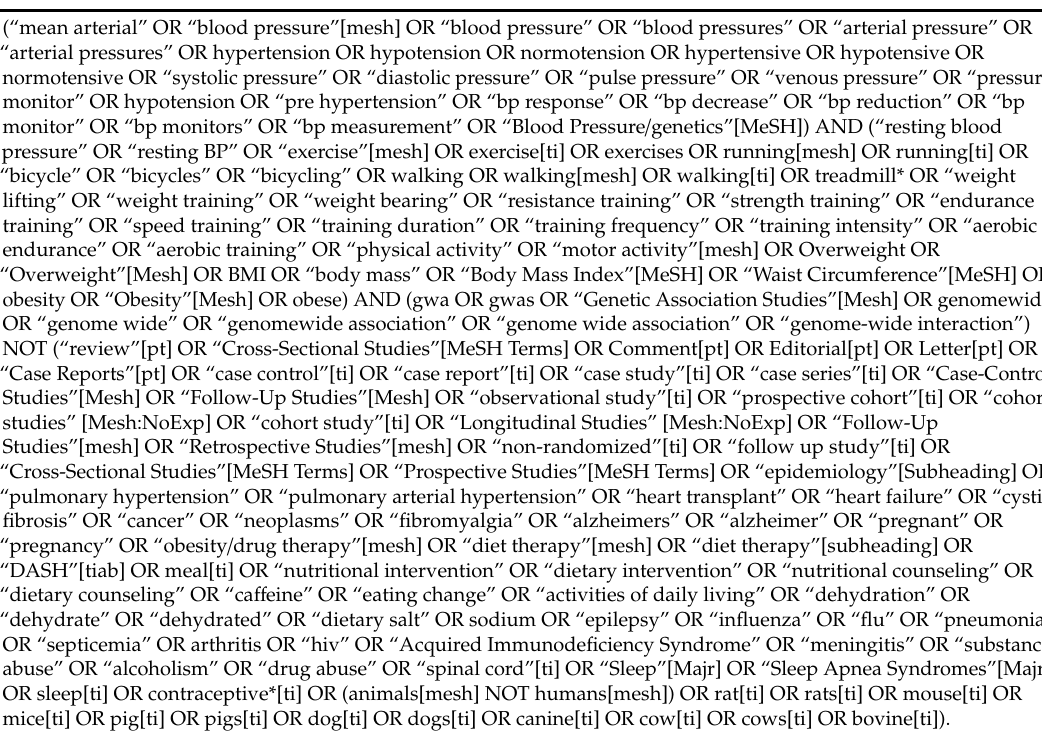
Table 4. Criteria 4a: Genes (n = 27) in major blood pressure regulatory pathways associated with physical activity and / or obesity in genome wide association studies. The search was conducted on 05 / 11 / 2017 and a total of 188 records were